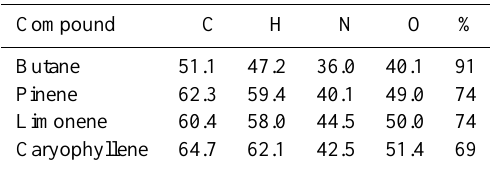
Table 3. Mass weighted average location of C, H, N, and O cal- culated by high resolution AMS analysis of m/z ≤ 100 (first four columns) and the percent of organic mass located ≤ m/z 100 eval- uated by unit mass resolution up to m/z = 500. Correction factors for non-uniform detection of C, H, N, and O have not been applied to the